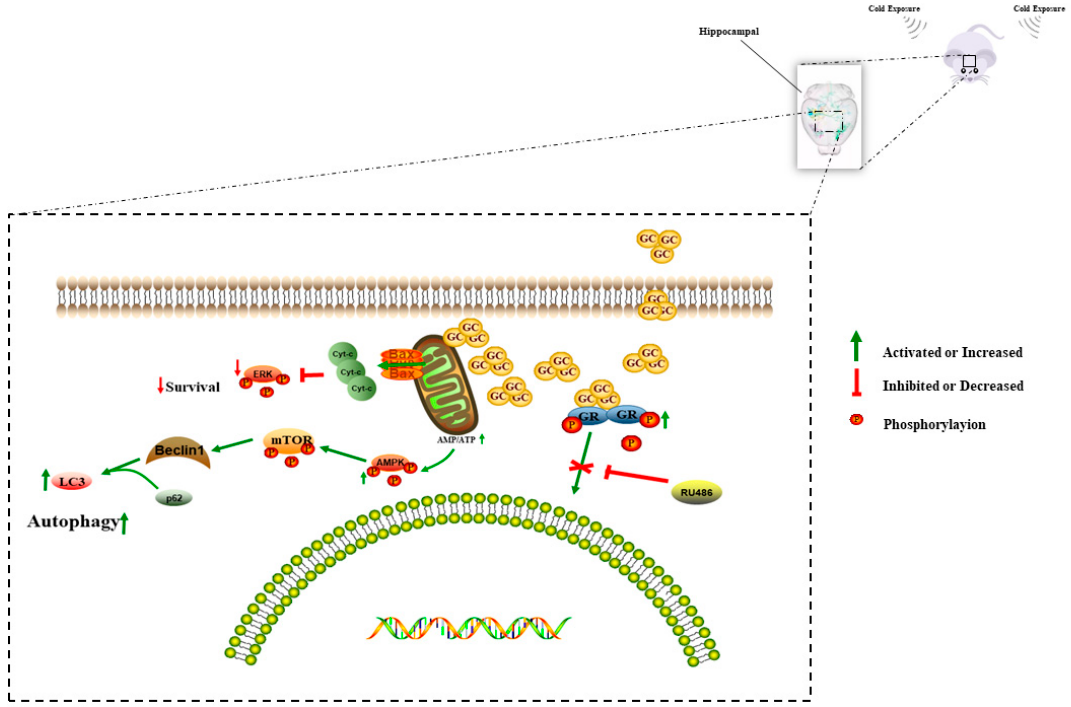
Figure 12. A proposed model for molecular mechanisms involving neuronal autophagy related to cold stress via 400 μ M cortisol in the hippocampi of adolescent mice.